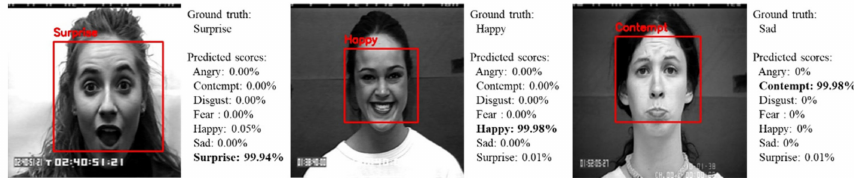
Figure 6. Prediction results of the proposed method. Red boxes indicate faces detected by the landmark